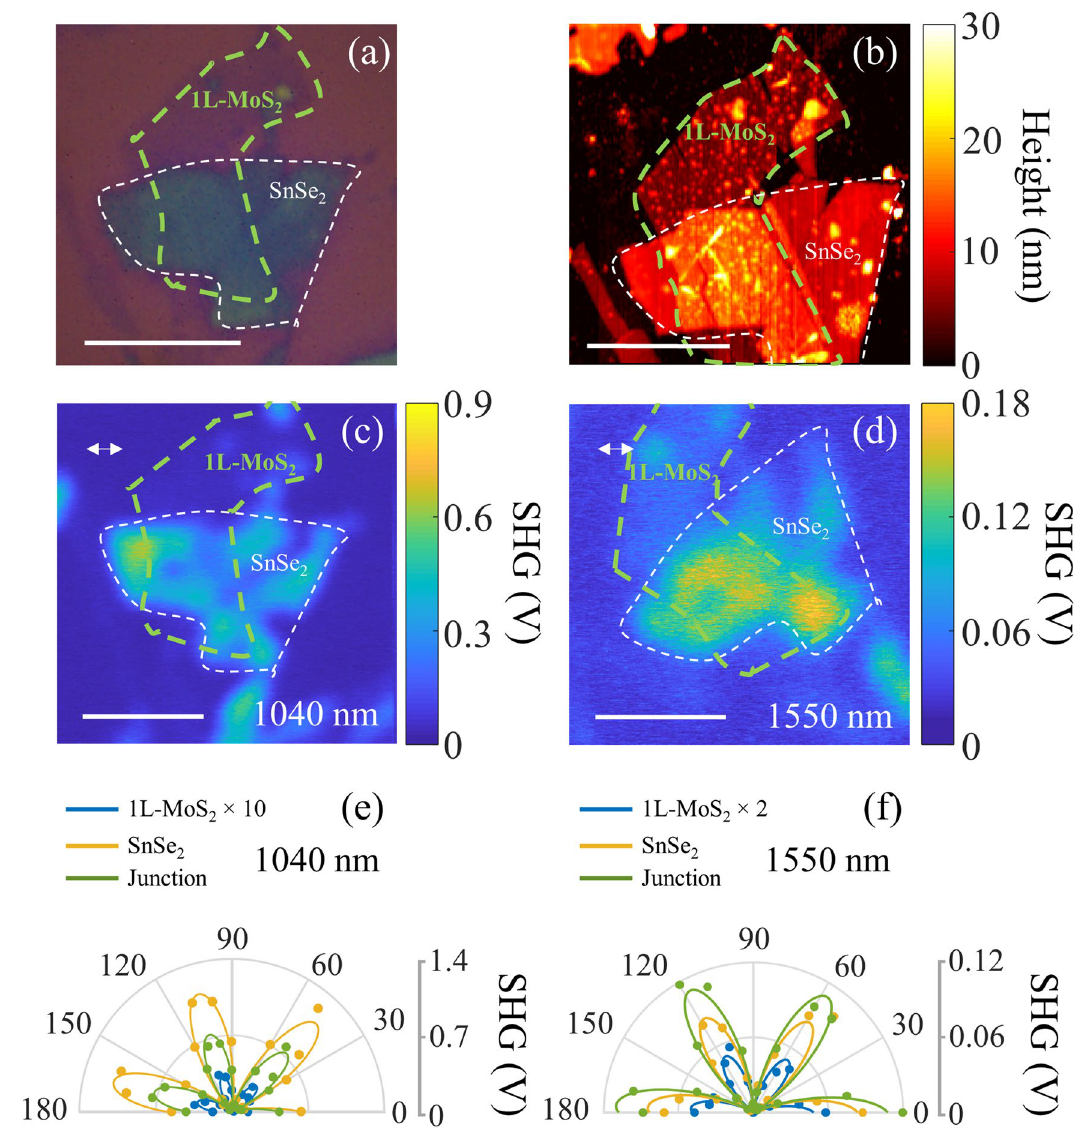
Figure 6. SHG from monolayer (1L) MoS 2 /multilayer SnSe 2 heterostructure. ( a ) Optical brightfield image of the heterostructure with green and white dashed boundaries delineate the boundary of MoS 2 and SnSe 2 respectively. ( b ) AFM image of the heterostructure. SHG images acquired for ( c ) 1040 nm, and ( d ) 1550 nm excitation wavelengths. The scale bar in the images corresponds to 5 μm. Polarization dependent SHG polar plots shown for ( e ) 1040 nm and ( f ) 1550 nm excitation wavelengths. The polar plots corresponding to MoS 2 region (blue curve), SnSe 2 region (orange curve) and overlap junction region (green curves) are shown. The experimental data and six-fold fit are shown by filled circles and solid curves respectively. (Created in MATLAB v9.6, R2019a, https:// in. mathw orks.